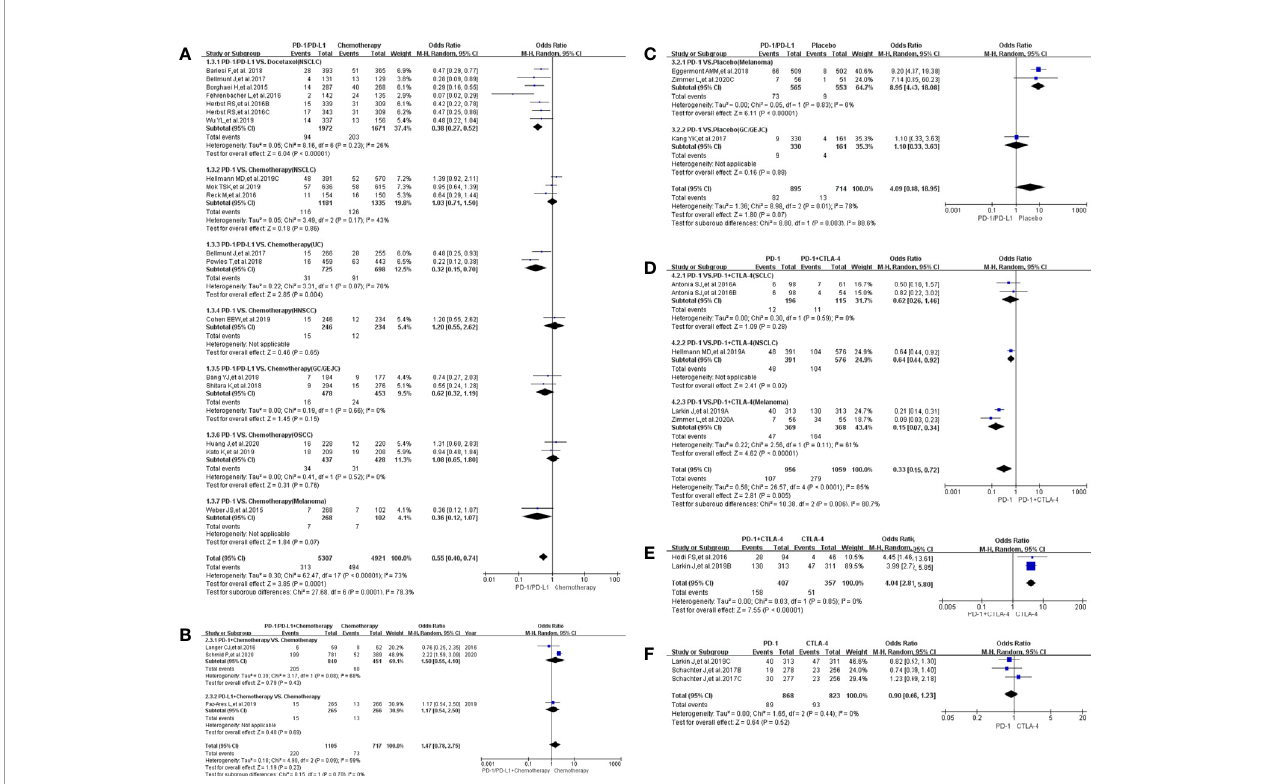
FIGURE 4 | Forest plots of treatment-related adverse events leading to discontinuation of therapy. (A) The odds ratio of treatment-related adverse events leading to discontinuation of therapy calculated by the random effect (RE) model in Group A (PD-1/PD-L1 vs Chemotherapy): subgroup analysis was performed based on tumor types, PD-1/PD-L1 and treatment regimens. (B) The odds ratio of treatment-related adverse events leading to death calculated by the random effect (RE) model in Group B (PD-1/PD-L1 + Chemotherapy vs Chemotherapy). Subgroup analysis was performed based on PD-1/PD-L1. (C) The odds ratio of treatment- related adverse events leading to discontinuation of therapy calculated by the random effect (RE) model in Group C (PD-1/PD-L1 vs Placebo). Subgroup analysis was performed based on tumor types. (D) The odds ratio of treatment-related adverse events leading to discontinuation calculated by the random effect (RE) model in Group D (PD-1 vs PD-1 + CTLA-4). Subgroup analysis was performed based on tumor types. (E) The odds ratio of treatment-related adverse events leading to discontinuation of therapy calculated by the random effect (RE) model in Group E (PD-1 + CTLA-4 vs CTLA-4). (F) The odds ratio of treatment-related adverse events leading to discontinuation of therapy calculated by the random effect (RE) model in Group F (PD-1 vs